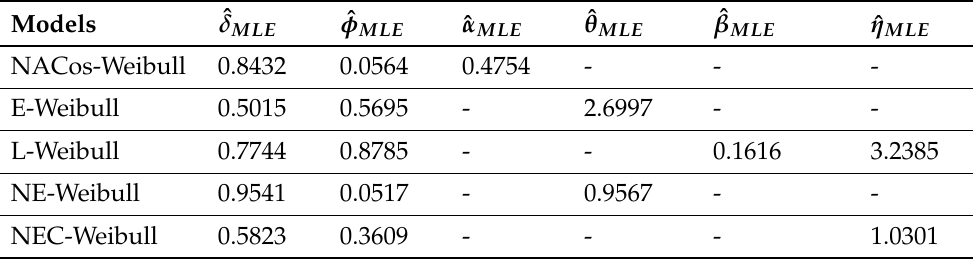
Table 5. Using the flood peaks data set, the values of ˆ δ MLE , ˆ φ MLE , ˆ α MLE , ˆ θ MLE , ˆ β MLE , and ˆ η MLE of the fitted distributions.